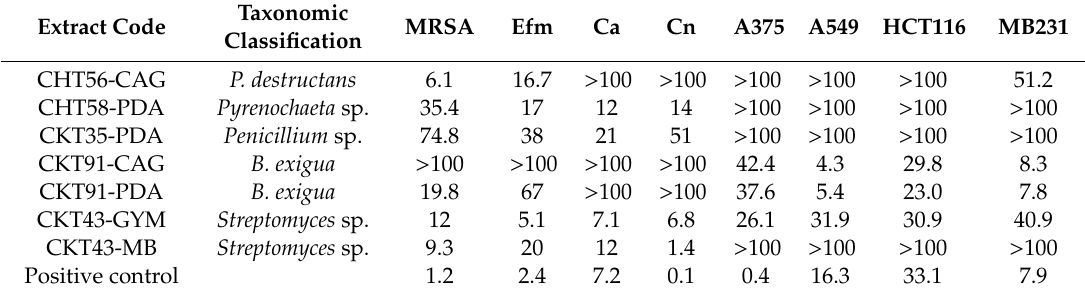
Table 1. Antimicrobial and anticancer activities of selected extracts. IC 50 values are expressed in µ g / mL. Cryptococcus neoformans , A375: Malignant melanoma, A549: Lung carcinoma, HCT116: Colon